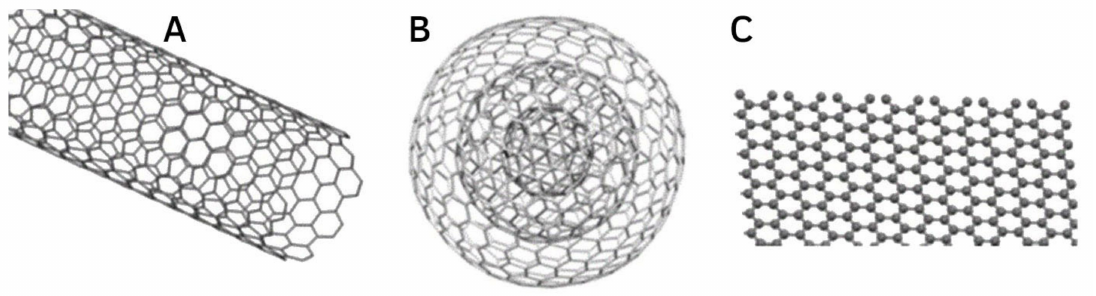
Figure 4. Structures of ( A ) single-walled CNT, ( B ) CNO, and ( C ) graphene. Adapted with permission from Ref. [40]. Copyright 2015 Royal Society of